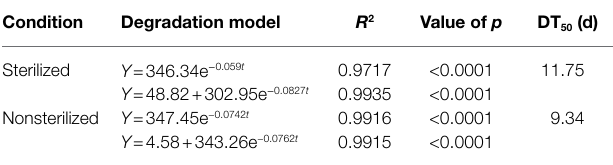
TABLE 3 | Degradation model of Cry1Ah protein in the soil